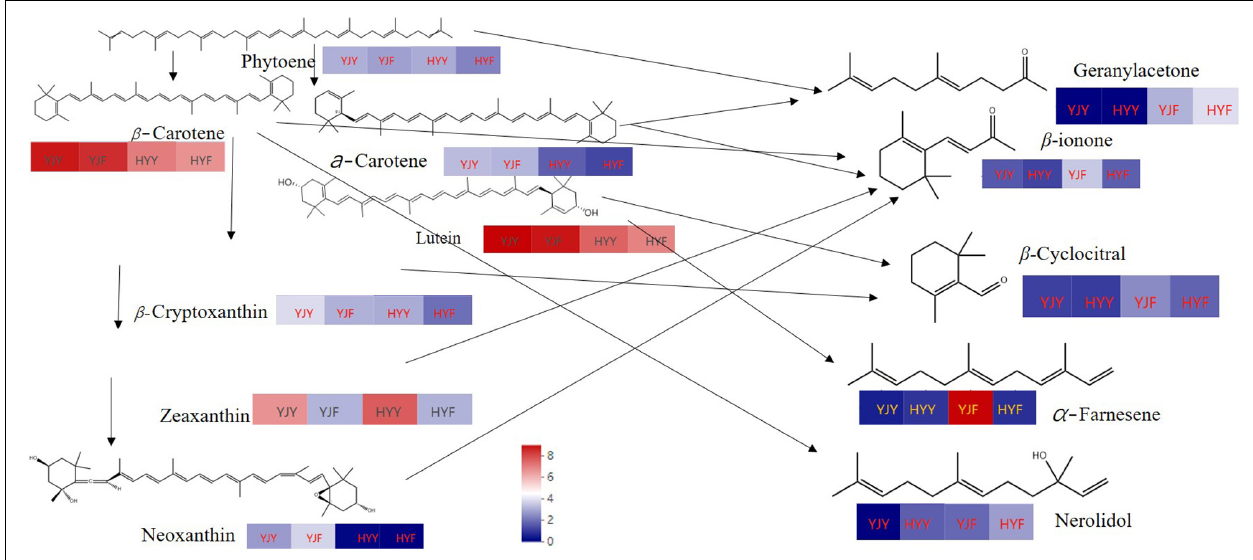
FIGURE 7 | The content of main types of carotenoids metabolism schematic and degradation products (main aroma compounds). Red and blue indicate higher and lower abundances, respectively. YJY was “Yinghong 9” fresh leaves, YJF was “Yinghong 9” fermented leaves; HYY was “Huangyu” fresh leaves, HYF was “Huangyu” fermented